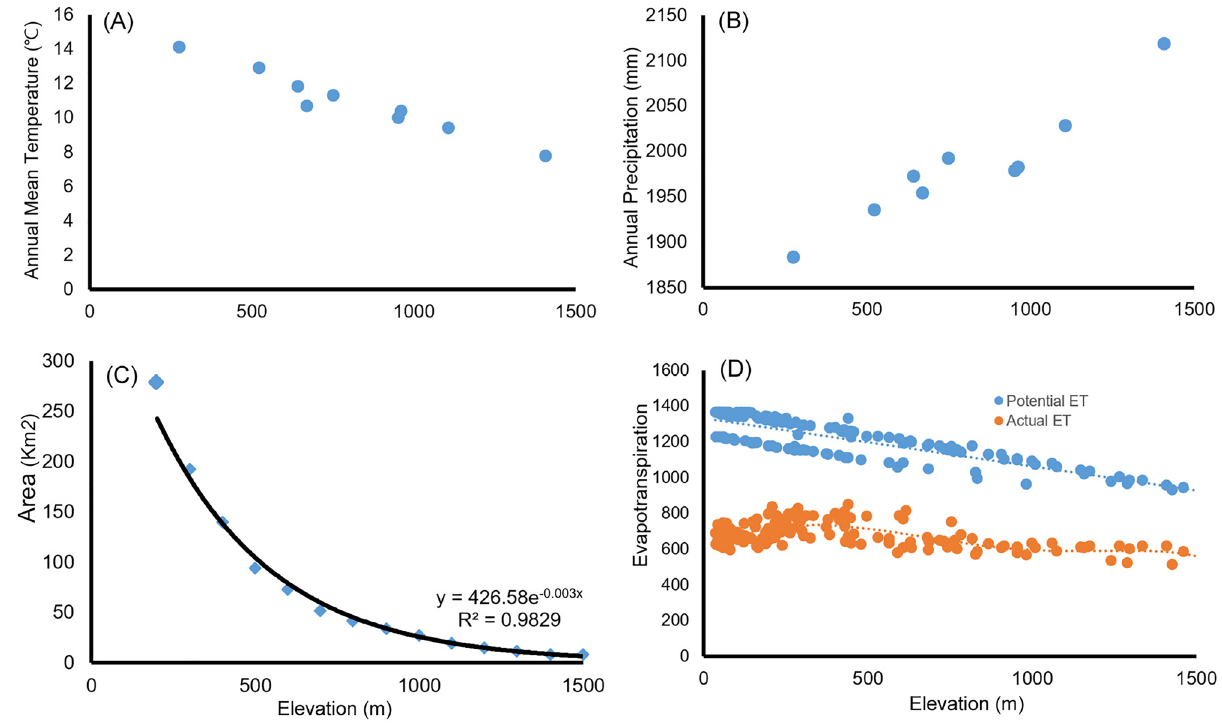
Figure 4. Changes in ( A ) annual mean temperature (°C), ( B ) annual precipitation (mm), ( C ), area (Km 2 ), and ( D ) potential ET (evapotranspiration) and actual ET (evapotranspiration) (mm) along elevation in species richness along a gradient of elevation is consistent in temperate and tropical mountains but a few species dominate the harsh condition. The best-known relationship between area and the number of species is often explained by the availability of habitat and resources since larger areas that comprised diverse habitats and ample resources support a large number of species in a given area 8 . In most mountain regions, the area declines monotonically with elevation but the species richness largely peaks at mid-elevation 18,20,34,35 . Many hypotheses were tried to explain this pattern including geometric constraints, phylogenetic history, past climatic variation, turnover at ecotones, specific biotic interactions, area-integrated productivity, and anthropogenic disturbance 13 . We found that the elevational area was not the driving variable for the number of species but the number of individuals. The negative relationship between the number of individuals and the elevational area could be attributed to a few dominant species in high elevations. The asymmetric rate of decline in diversity at mid-point elevations has been documented for many taxa (e.g., ants and geometrid moths) on different tropical mountains 47,48 . The higher loss of species diversity below the mid-point is probably due to deforestation or habitat disturbance in low-elevation areas 49 . The elevational pattern of the total diversity of moths in the present study differed somewhat from this trend, with species diversity being high at low elevations. This could be due to either the largely missing data from the lower-elevation areas or the result of the smaller land area of the island mountain (Fig. 4). The lower-elevation area of Jeju-do Island (300–400 m a.s.l.) is characterized by many low volcanic hills (“O-reum” in Korean), and these low volcanic hills are covered with coniferous and deciduous mixed vegetation at low and middle elevations and grasses on the hilltops. The habitat heterogeneity of this habitat and the massive postglacial colonization are the reason for the diversity of insects 50 and genetic diversity of the plants in this area (e.g., Quercus species) 51 . However, high developmental pressure on the coastal and low-elevation areas of the island has resulted in a deterioration of this biodiversity 52 . Because most of our study sites in the northern aspect were above the boundary of the national park, the diversity pattern below 500 m was excluded. Additionally, the high-elevation areas of the island mountain in our study area are smaller, thus limiting the total number of moth species and individuals. The plot of the number of individuals against elevation is hump-shaped and nearly symmetrical (Fig. 1). Although the number of species was small at high-elevation sites, there were a few dominant species of Geometridae ( Alcis angulifera, Menophra senilis, Parectropis nigrosparsa ), Noctuidae ( Diarsia pacifica ), and Erebidae ( Hydriollodes morosa, Ghoria gigantea, Dolgoma cribrata ) that occurred widely across all elevations (Fig. S1). This phenomenon, known as density compensation, explains the higher abundance of some species due to competition or predator relaxation 4–6 . The altitudinal distribution of Alcis angulifera, a polyphagous geometrid moth, is an example of density compensation: the species was found at all survey sites but was in higher abundance at low and mid-elevations (between 525 and 752 m). A noctuid moth Diarsia pacifica , feeding on composite plants (Asteraceae) occurred at all survey sites but was in higher abundance at high elevations (1410 m). The high number of occurrences of these common moth species on the island mountain could be the